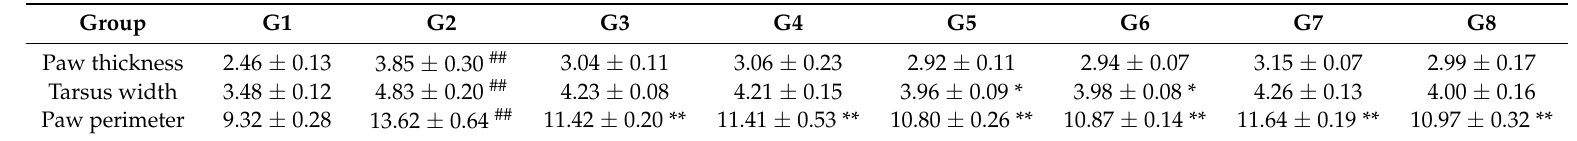
Table 2. The changes of mice paw thickness, tarsus width and paw perimeter on the last day of the experiment. (X ± SD, n = 12 or 8, mm). Group